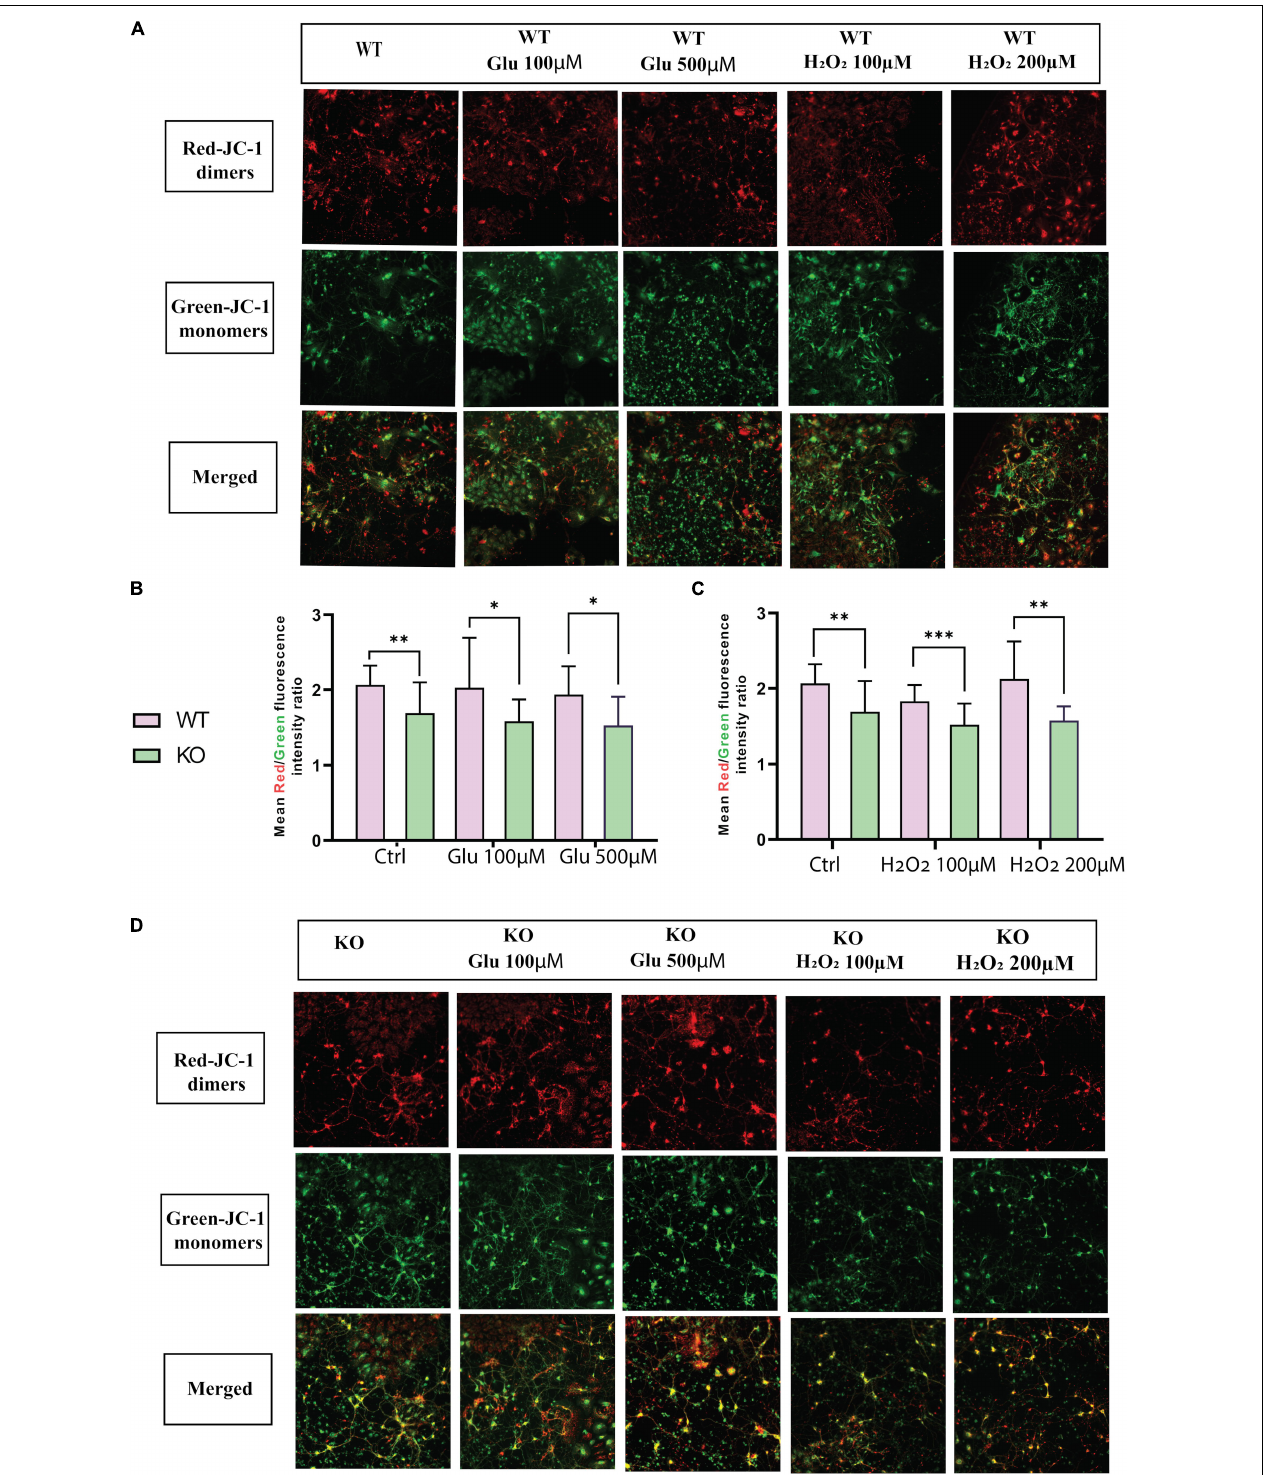
FIGURE 3 | MMP (cid:49)(cid:57) m was measured in primary cortex cells of WT (A) and KO (D) under different treatments of glutamate and hydrogen peroxide using the JC-1 dye. Images were captured using ImageXpress from a molecular device. The fluorescence intensity was measured for both JC-1 green for J-monomers or red for J-aggregates. The graph represents the means of the ratio of fluorescence intensity of red aggregates/green monomer per image for WT and KO primary cortex cells under glutamate toxicity (B) and hydrogen peroxide (C) treatments. Unpaired t -test was performed to compare KO and WT for cells exposed to glutamate excitotoxicity (B) and oxidative stress (C) with significance levels ( ∗ ≤ 0.05, ∗∗ ≤ 0.01, and ∗∗∗ ≤